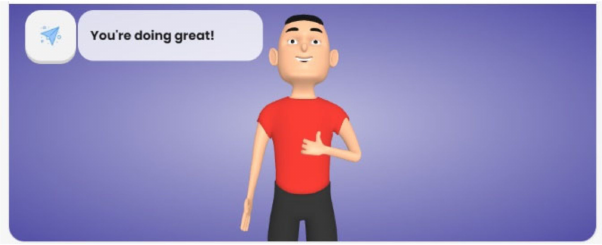
Figure 5. Representation of a message exchanged by the cognitive assistant.